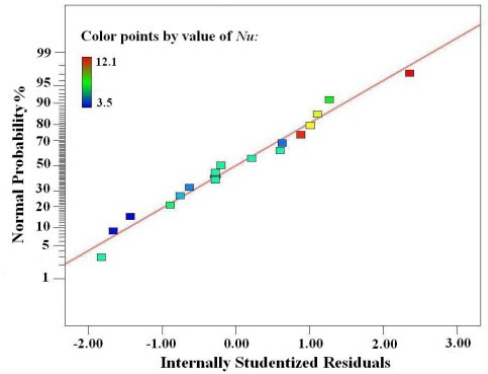
Figure 3. Normal plot of residuals for 18 typical tested points.